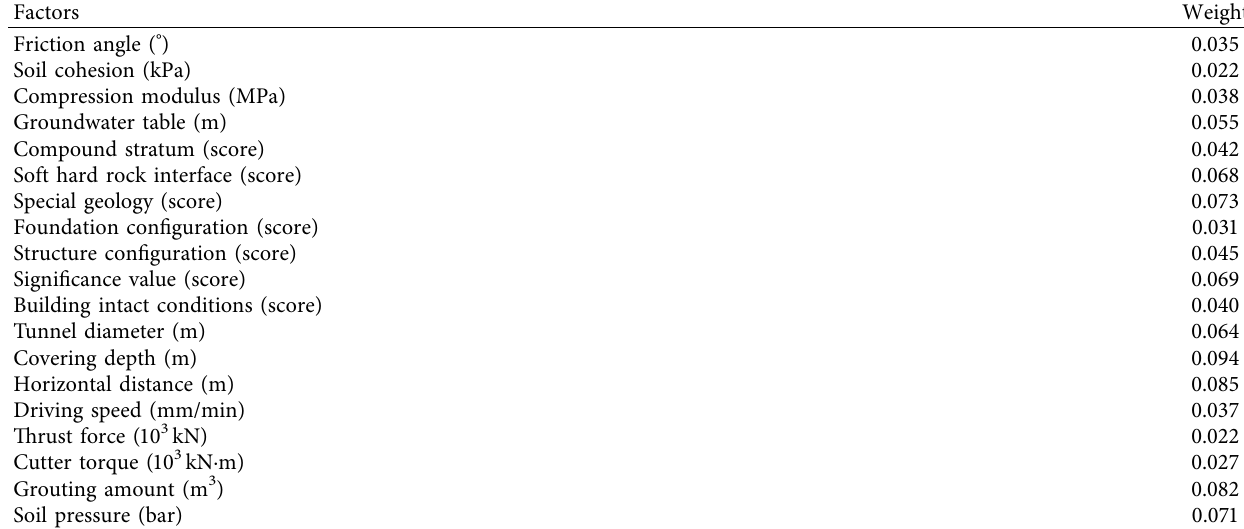
Table 10: Te normalized weights of each infuence